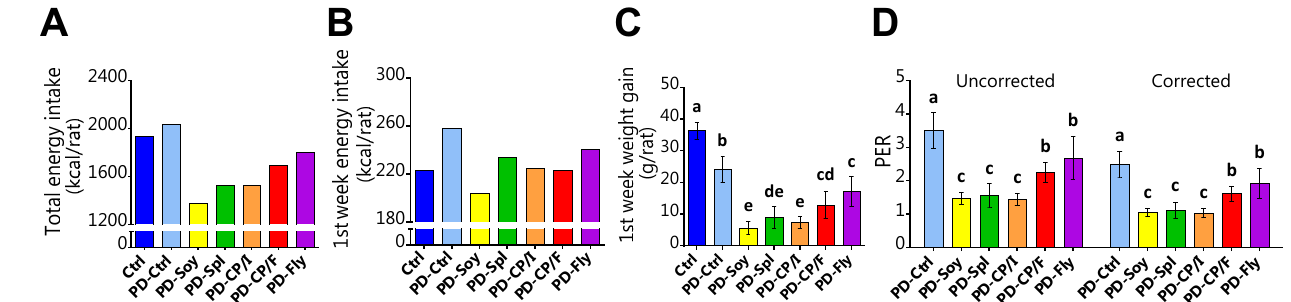
Figure 3. Energy consumption and utilization. ( A ) Total energy intake (kcal\rat). ( B ) 1st week total energy intake (kcal/rat). ( C ) 1st week total weight gain (g\rat). ( D ) Protein Efficiency Ratio (PER). Relative weight gain (g) per protein intake (g). PER examined under standardized conditions of weaning rats that were fed 10% protein in the diet for a test period of 4 weeks. Corrected PER values are standardized for PD-Cas = 2.5. Values are expressed as mean ± SD of n = 8 rats/group, different superscript letters are significantly different ( p < 0.05) by one-way ANOVA followed by Tukey’s test.